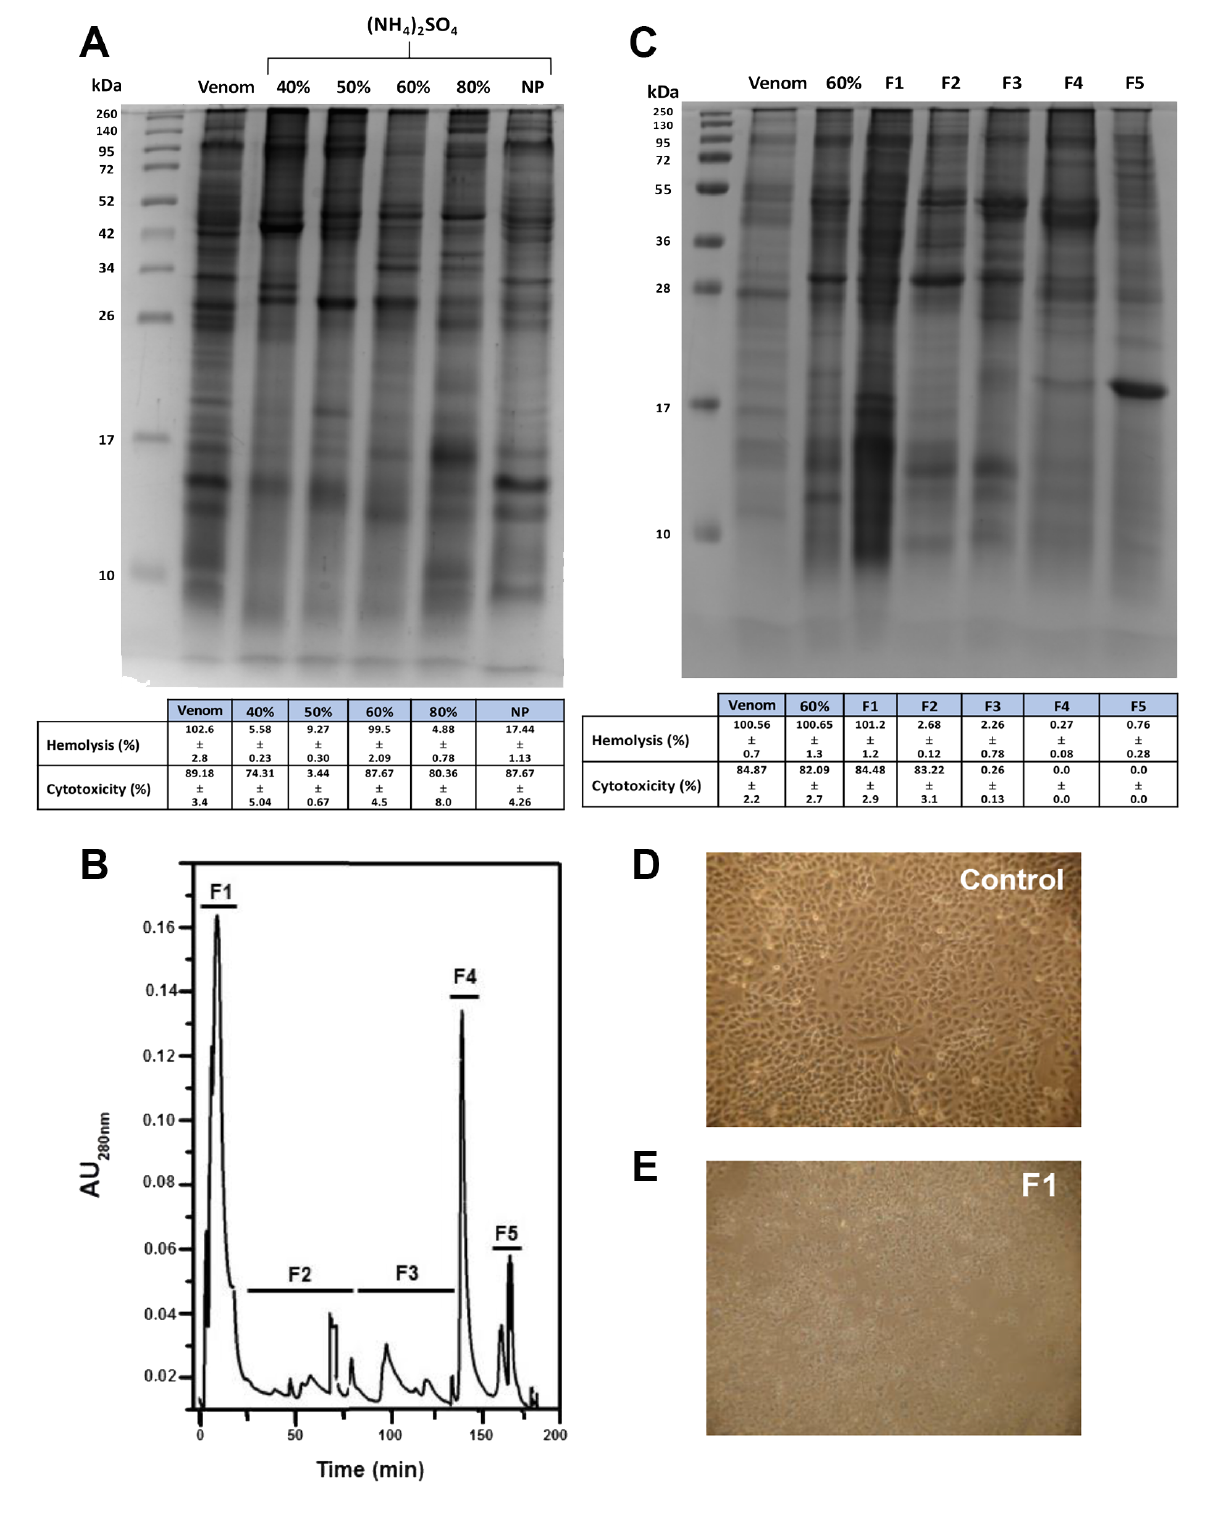
Figure 2 Venom fractionation. A . Gradual precipitation of venom with ammonium sulfate. SDS-PAGE, hemolytic activity in human red blood cells, and cytotoxicity in A549 cells determined by released LDH. B . Anion exchange chromatography of proteins precipitated with 60% ammonium sulfate. Five fractions were obtained by chromatography (F1: 0 mM NaCl, F2: 20 - 60 mM NaCl, F3: 80 - 100 mM NaCl, F4: 200 mM NaCl, F5: 300 mM NaCl). C : Denaturing electrophoresis of the fractions obtained in B, hemolytic activity in human erythrocytes and cytotoxicity in A549. D and E : A549 cells without and with F1,